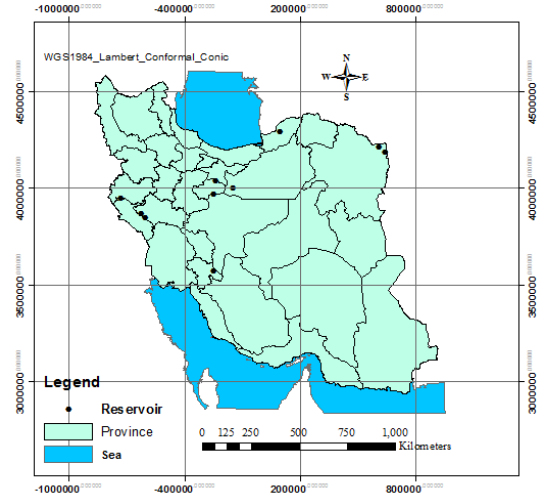
Figure 7- Location of 10 existing reservoirs in the country